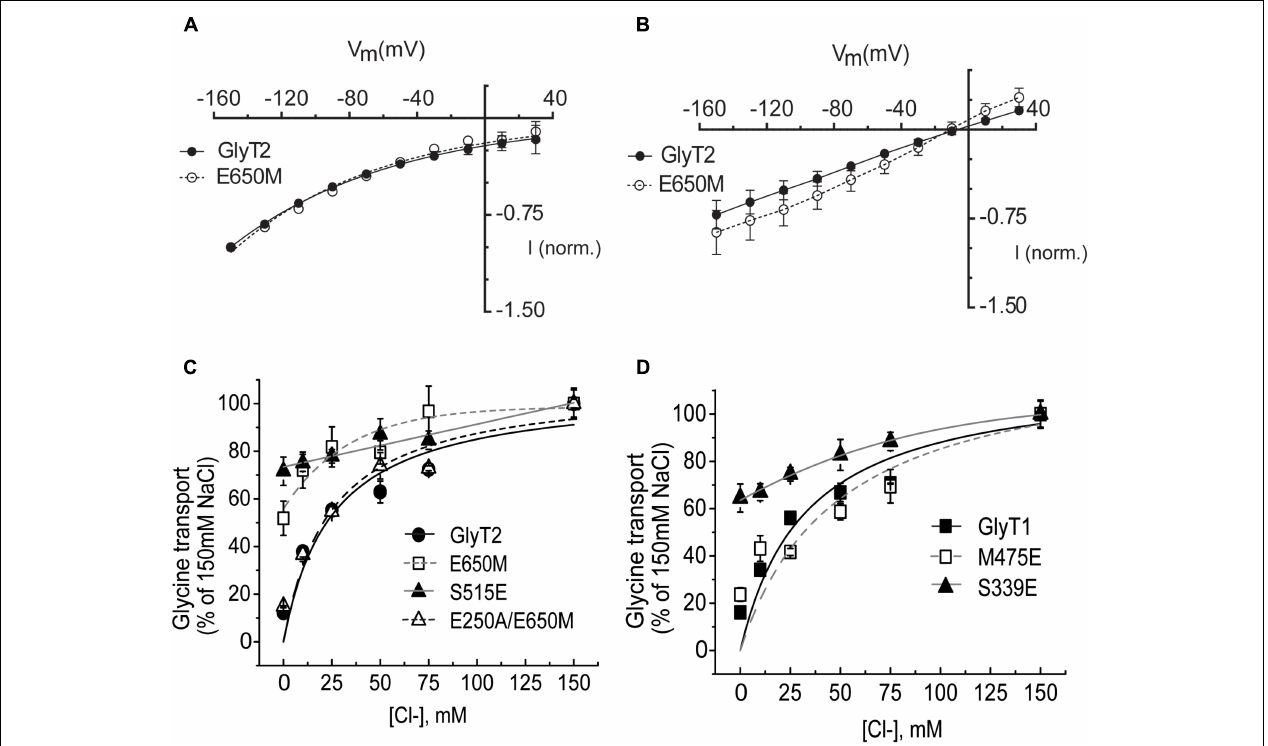
FIGURE 9 | Chloride dependence of glycine-induced steady-state currents and glycine transport by wild-type GlyTs and mutant transporters. (A,B) Glycine-induced currents: the membrane voltage of oocytes expressing the indicated transporters was stepped from a holding potential of –60 mV to voltages between –150 to 30 mV in –20 mV increments. Currents in 100 mM NaCl recording solution (A) or in chloride-free solution (described in material and methods) (B) were subtracted from those in the same medium supplemented with 1 mM Gly. At each potential glycine-induced currents were averaged and normalized to those at –150 mV. (C,D) COS7 cells expressing the indicated transporters were assayed for glycine transport in the presence of increasing extracellular NaCl concentrations (isotonic substitution by sodium gluconate). Control glycine transport by wild-type GlyT2 and GlyT1 was 3.3 ± 0.3 and 2.6 ± 0.3 nmol glycine/mg protein/10 min, respectively. Representative experiments are shown repeated at least in three separated experiments performed in quadruplicate. Experimental data were fitted to the Michaelis–Menten